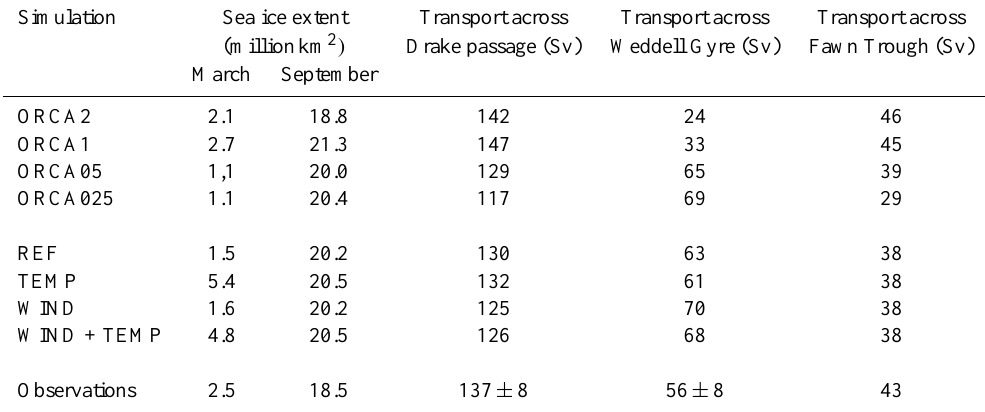
Table 2. Sea ice extent, zonal transport through Drake Passage, through Weddell Gyre along the Greenwich Meridian and through Fawn Trough for all simulations (period 1985–1989). The definition of the sea ice extent used here is the area where sea ice concentration is greater than 15%. Observations come from Fetterer and Knowles 2004) (SSMI data) for sea ice extent, from Cunningham et al. (2003) for transport through Drake Passage, from Klatt et al. (2005) for the transport in the Weddell Gyre along the Greenwich Meridian and from Park et al. (2009) for the transport across Fawn Trough. Simulation Sea ice extent Transport across Transport across Transport across Drake passage (Sv) Weddell Gyre